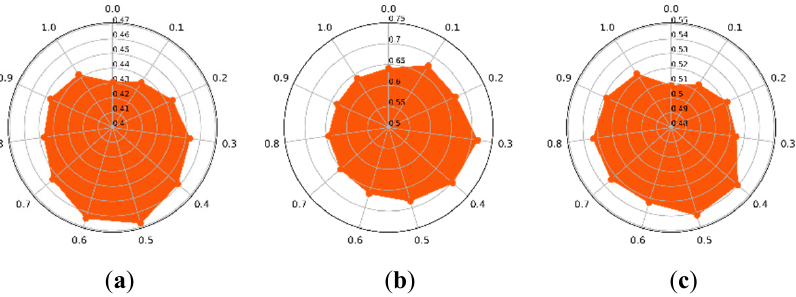
Figure 8. The impact of α on the proposed CLAP. ( a ) Indian Pines dataset. ( b ) Pavia University dataset. ( c ) WHU-Hi-HongHu dataset.